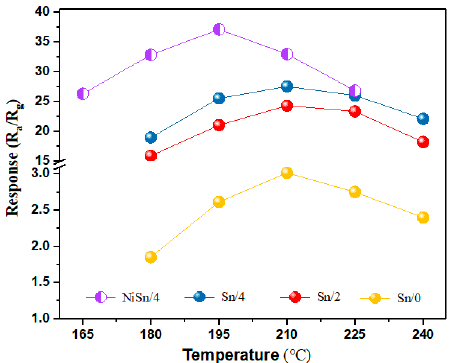
Figure 6. Gas response of the Sn/0, Sn/2, Sn/4 and NiSn/4 sensor devices to 100 ppm H 2 under different operation temperatures.